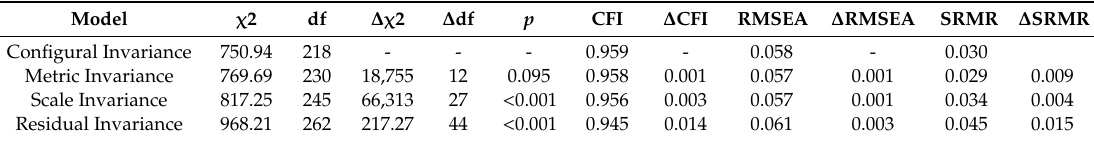
Table 5. Goodness-of-Fit Indexes of the multigroup analysis between the Portuguese and Brazilian